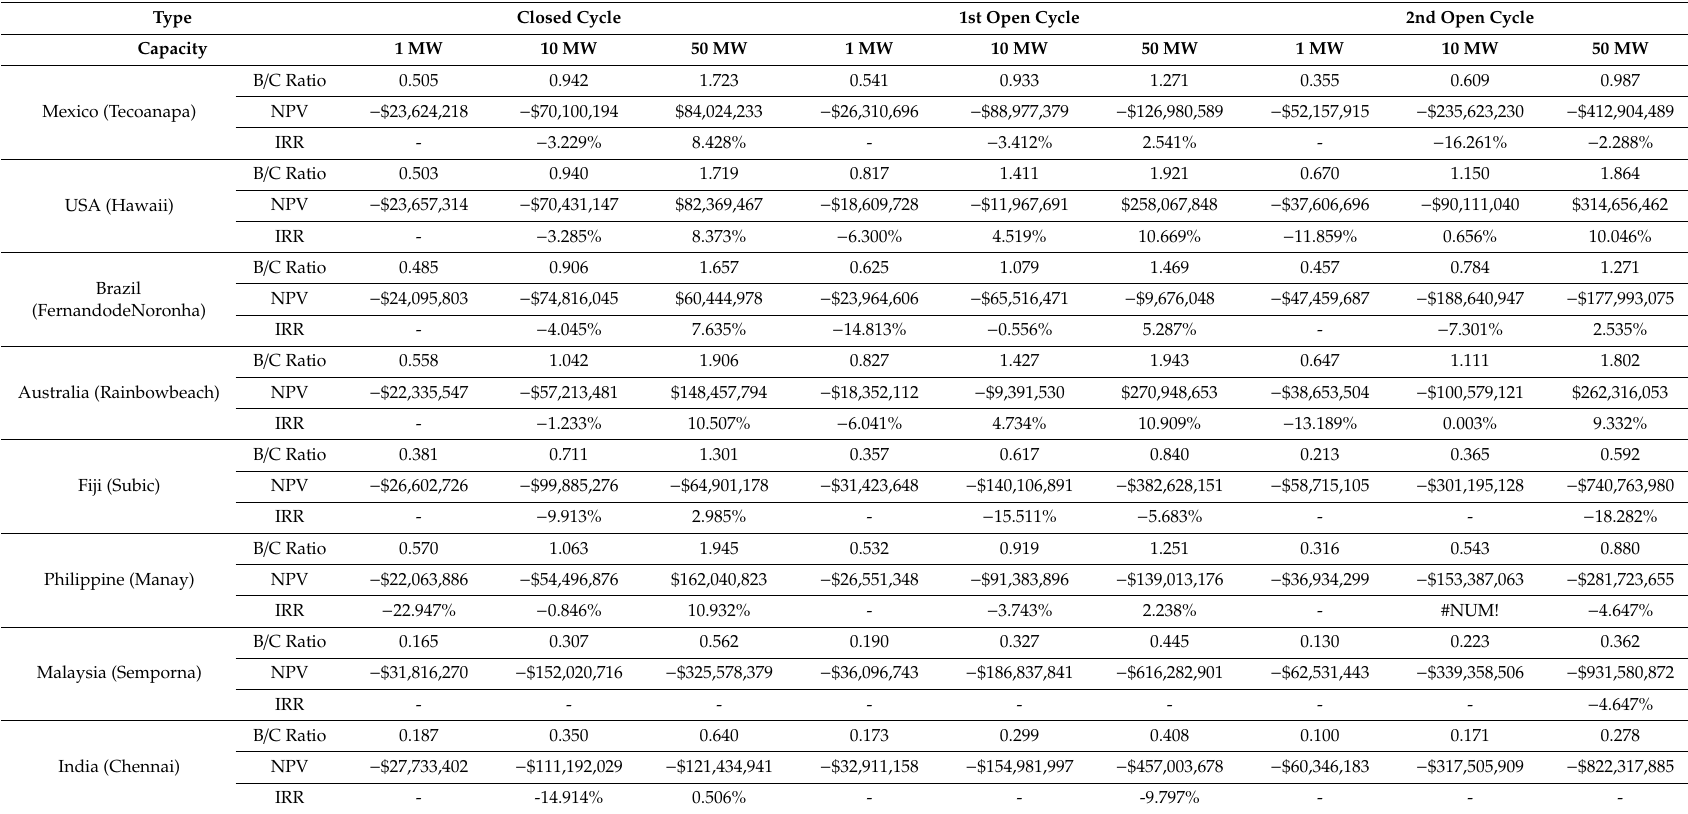
Table 4. Economic analysis according to OTEC’s